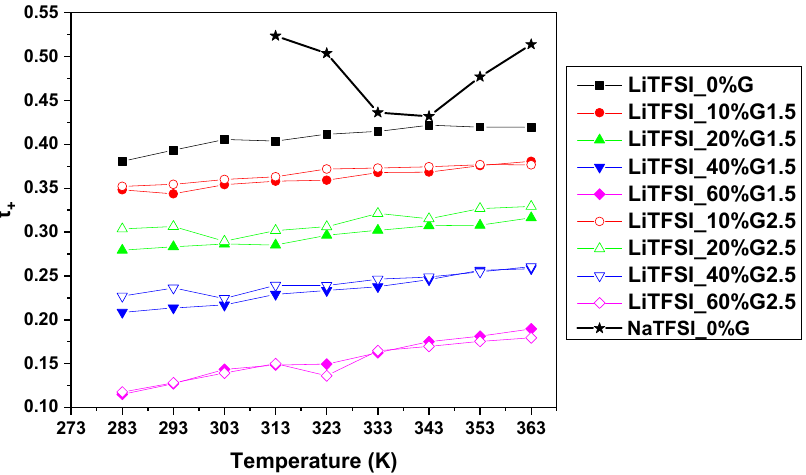
Figure 6. Temperature dependence of cation transference numbers for NaTFSI_0%G electrolyte and LiTFSI electrolytes with different amounts of PAMAM. The solid lines are guides for the eye.